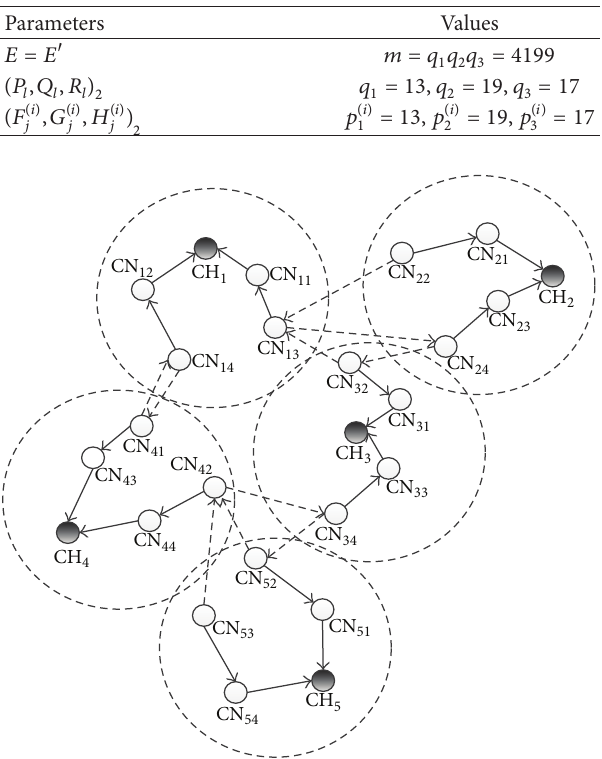
Table 1: The values of the major parameters.